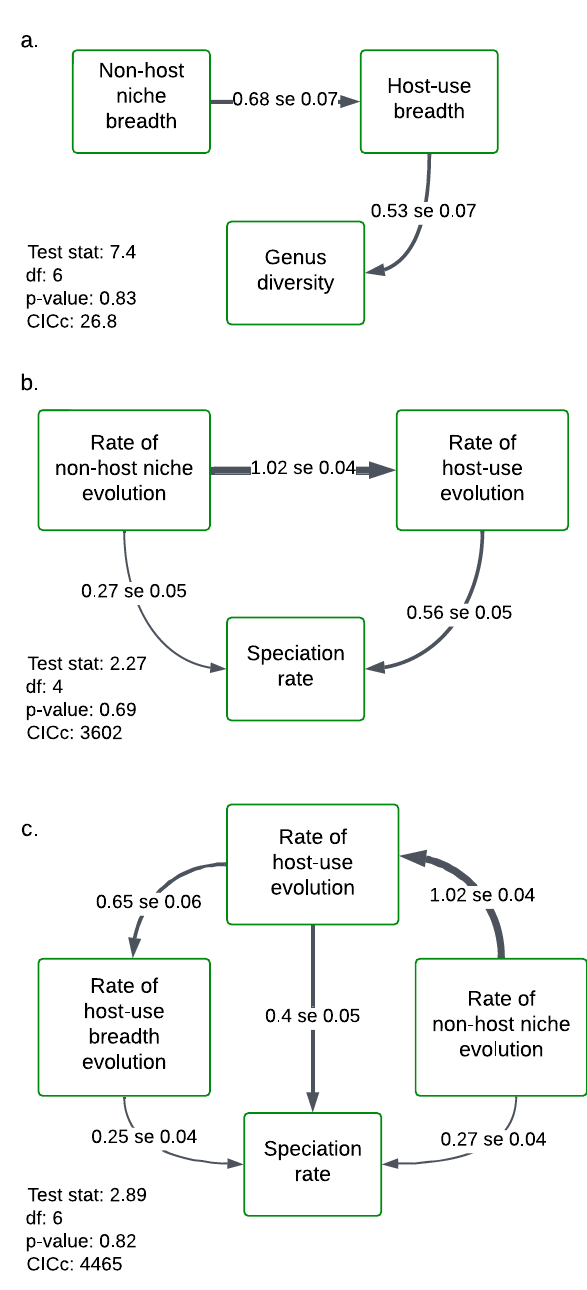
Fig. 2 Path models showing causal relationships between the evolution of niche components and species diversity in Nearctic aphids. Values on edges are standardized mean differences for the combined effects of the fi rst two principal components for variables representing environmental niches and host-use niches. Arrow width indicates relative strength of effect. The p -value provided for each model is for a Chi-squared tests of goodness- of- fi t; as a rule of thumb, values >0.5 indicate a good fi t to the data. a Best model of the causes of variation in the species richness of aphid genera. b Best model of how host-use evolution and environmental niche evolution affect speciation rate. c Best model of how the host-use evolution, host-use breadth evolution, and environmental niche evolution affect speciation evolution, and vice versa. In the best- fi tting model (Fig. 2b; AIC difference = 4465), the direct effect of non-host-related niche evolution on speciation was 0.27 SMD (±0.05 se), while its indirect effect (through its effects on host-use evolution) was 0.57